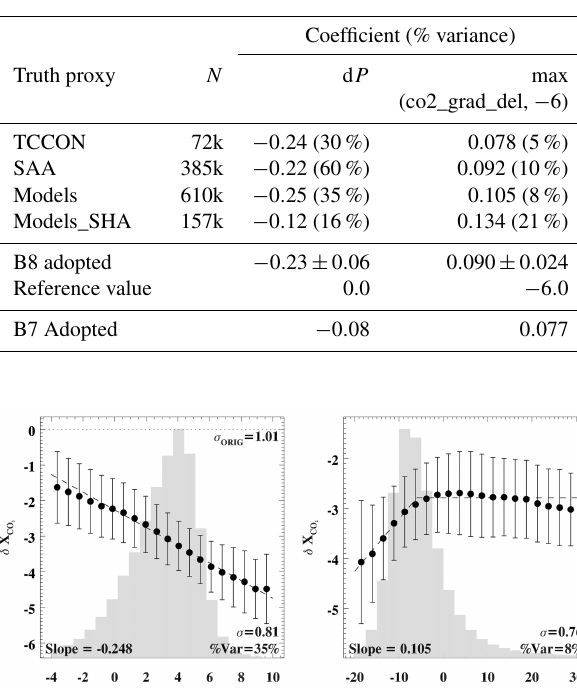
Table 10. Ocean glint bias-correction parameters for different truth proxies.